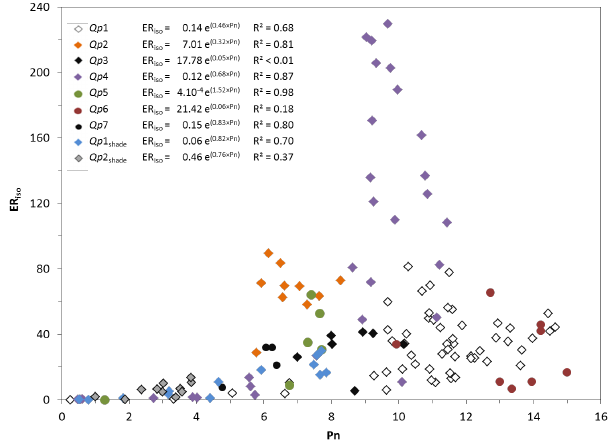
Figure 3. Isoprene emission rate ER iso (µgCg − 1 tosynthetic assimilation Pn (µmol CO 2 m − 2 s − 1 ) . Exponential de- pendency equation and determination coefficient R 2 are given for each Qp i